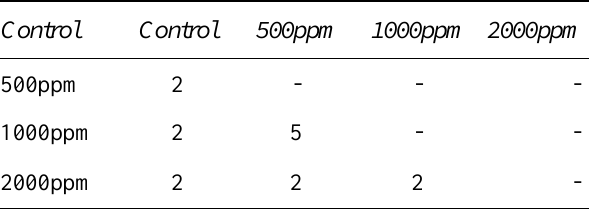
Table 2: Pairwise comparison of nirK profiles from high- Pb experiments samples. Similarities are described by Jaccard Similarity Coefficient.